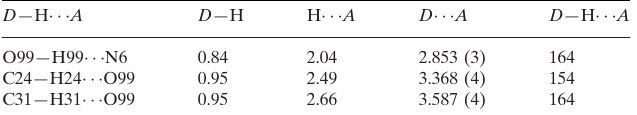
Hydrogen-bond geometry (A˚ , (cid:3)